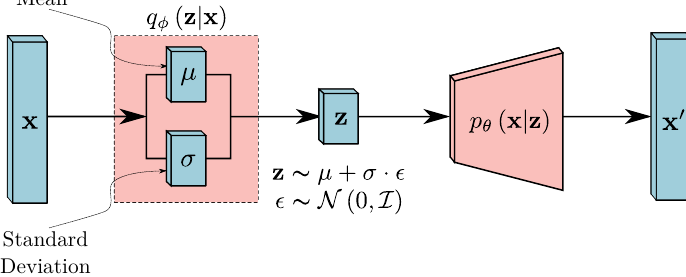
Figure 2. Illustration of the VAE